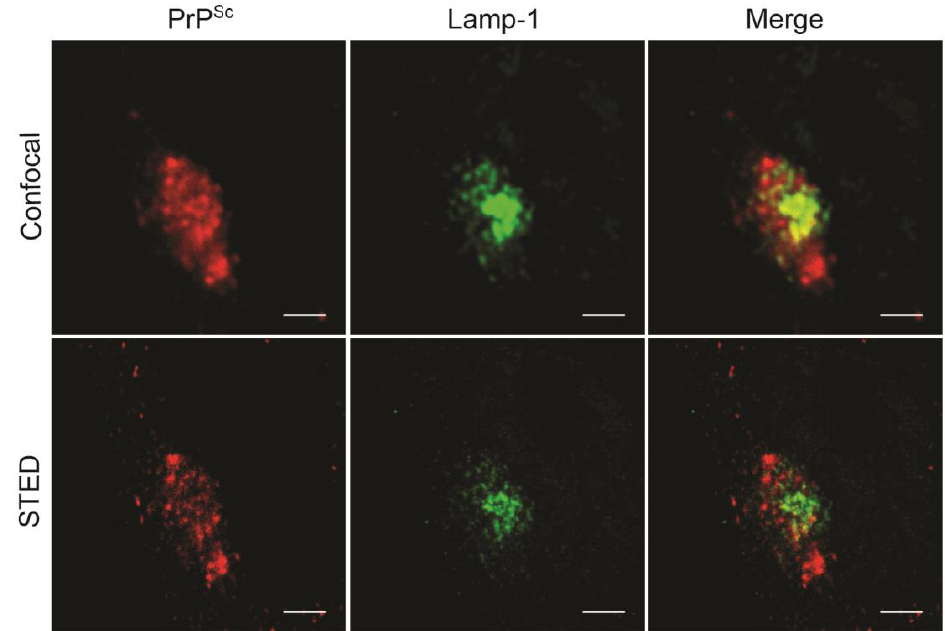
Figure 2. Comparison of spatial resolution of confocal microscopy and super resolution microscopy. N2a cells persistently infected with 22L were fixed and permeabilized, and antigens were denatured using 6 M guanidine hydrochloride. PrP Sc was detected using antibody 4H11 [97]. Lamp-1 was detected using rabbit polyclonal antibody ab24170 (Abcam). Scale bar: 20 µ m. Images were taken using the stimulated emission depletion (STED) microscope Leica TCS SP8 STED and a 93 × objective. A single plane is shown. STED microscopy provides better spatial resolution compared to conventional confocal microscopy (images courtesy of Valerio Bonaldo, Vorberg laboratory).